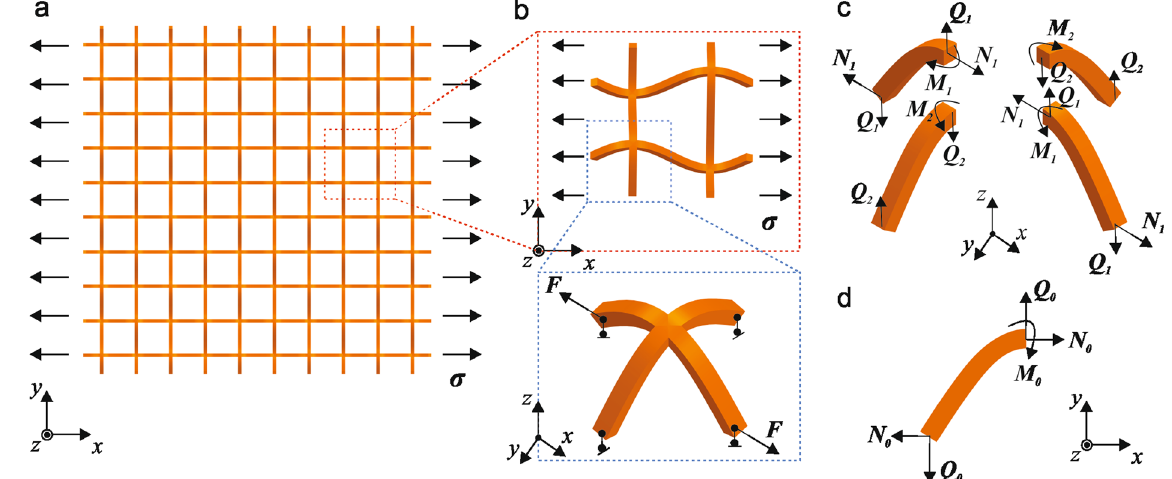
Figure 3. Schematics of the theoretical model of the 3D planar auxetic metamaterial subject to a uniform tensile stress along horizontal stretching: ( a ) the lattice materials with 5 × 5 unit cells under horizontal stretching is taken as an example to illustrate the model; ( b ) a representative unit cell is under horizontal stretching and due to the anti-symmetric one corner structure is analyzed; ( c ) free body diagrams of the corner structure; ( d ) a curved beam subject to axial forces, shear forces and a moment at the right